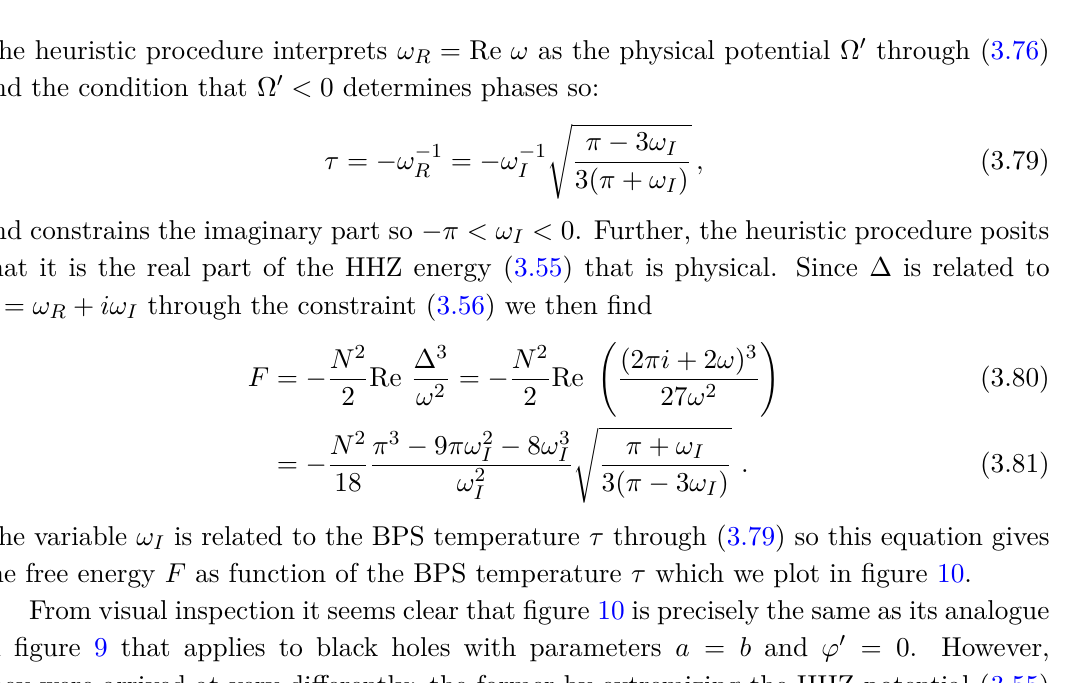
Figure 10 . The free energy F vs. the BPS temperature τ . This phase diagram was derived from the HHZ potential using the “heuristic”